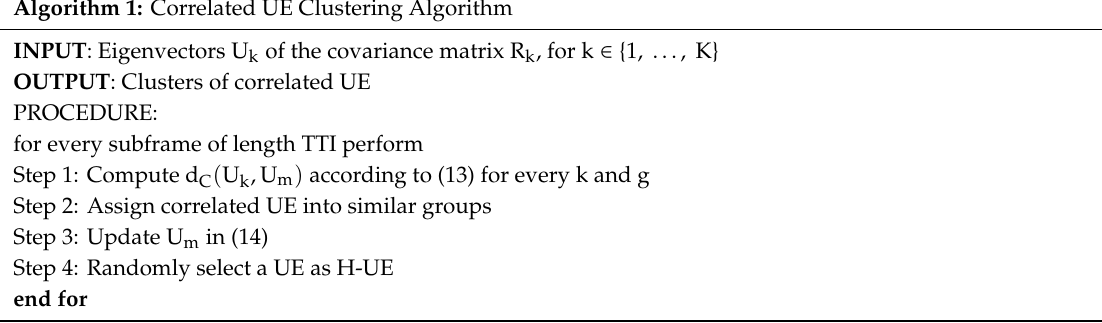
Algorithm 1: Correlated UE Clustering